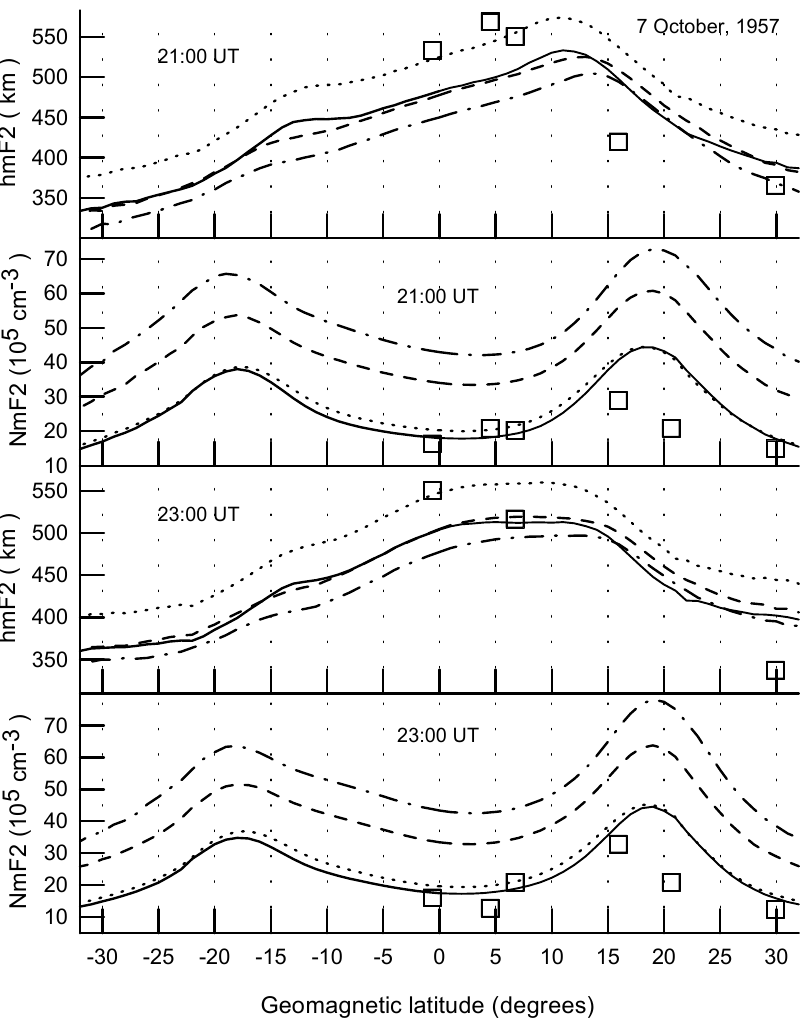
Fig. 10. Observed (squares) and calculated (lines) hm F2 and Nm F2 at 21:00 UT (two upper panels) and 23:00 UT (two lower panels) on 7 October 1957. The difference between the universal time and the local time at the geomagnetic equator is 05:12. The curves are the same as in Fig.